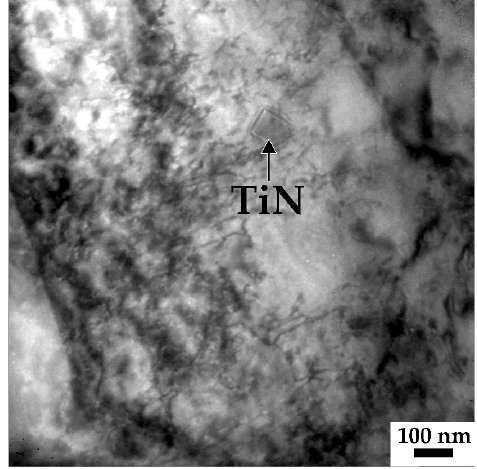
Figure 9. TEM micrograph of CGHAZ. The CGHAZ microstructure was followed by FGHAZ microstructure with peak tem- perature between A c3 (846 ◦ C) and 1100 ◦ C, which has 0.06292–0.01663% of f NbC (Figure 8b). The grain size of FGHAZ (7.14 µ m) became much smaller than that of CGHAZ (20.87 µ m), because of most of TiN and NbC without solution in this temperature range, which obvi- ously refine the austenite